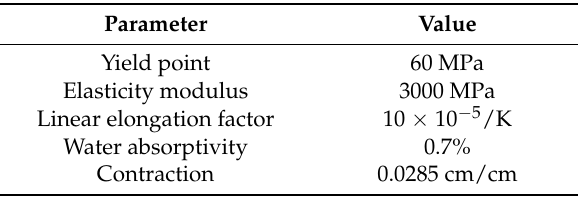
Table 2. Polyoxymethylene characteristics of